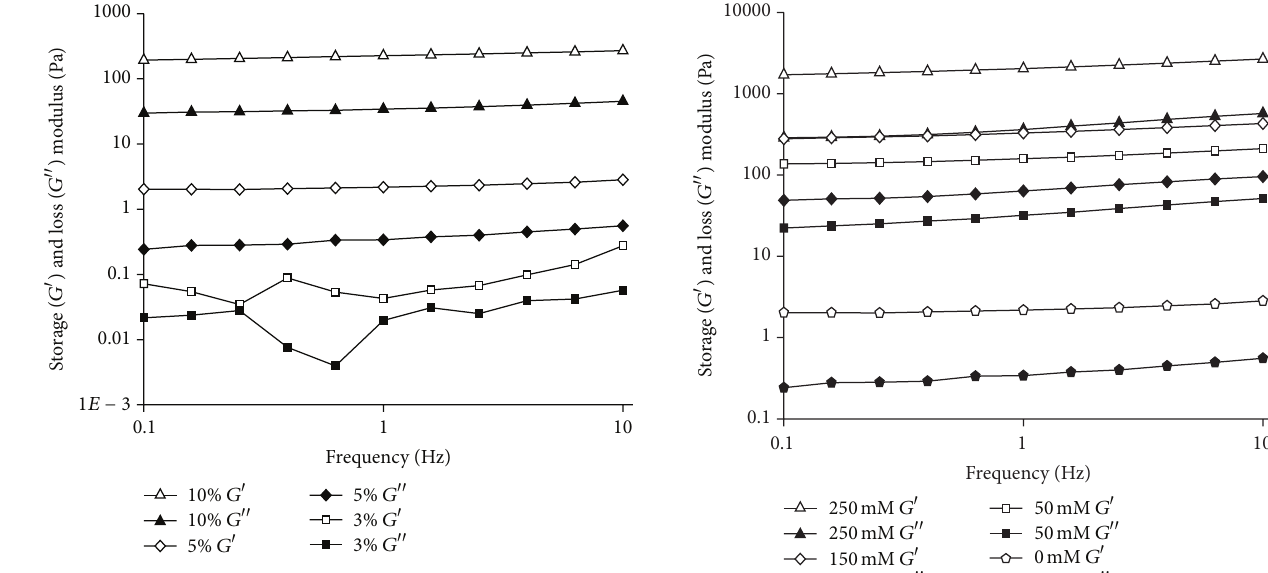
Figure 5: Frequency dependence of storage (𝐺 󸀠 ) and loss (𝐺 󸀠󸀠 ) modulus of different concentration of LP.